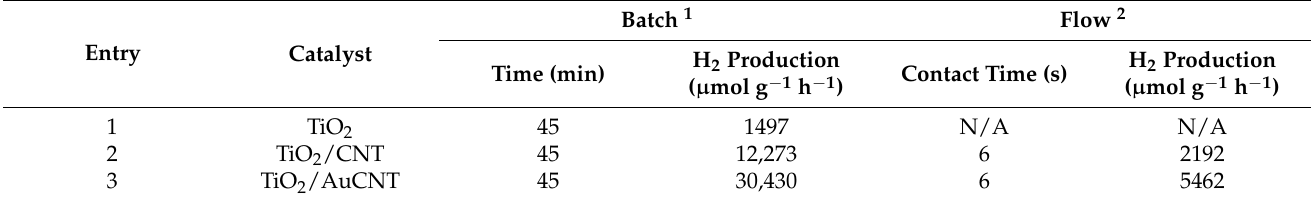
Table 1. Photocatalyzed hydrogen production with different TiO 2 -based systems, in batch and in